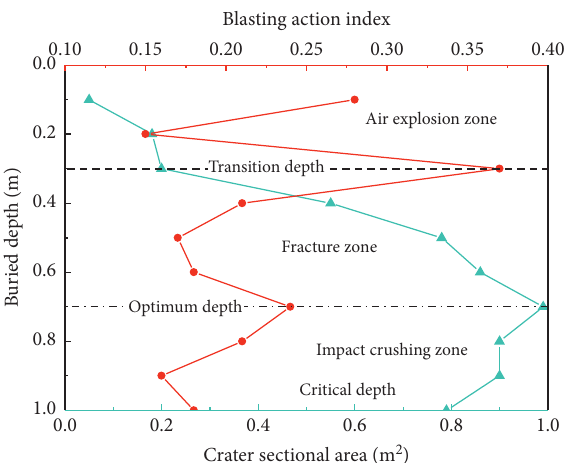
Figure 13: Sectional area and crushing index of the blasting crater – buried depth of explosive